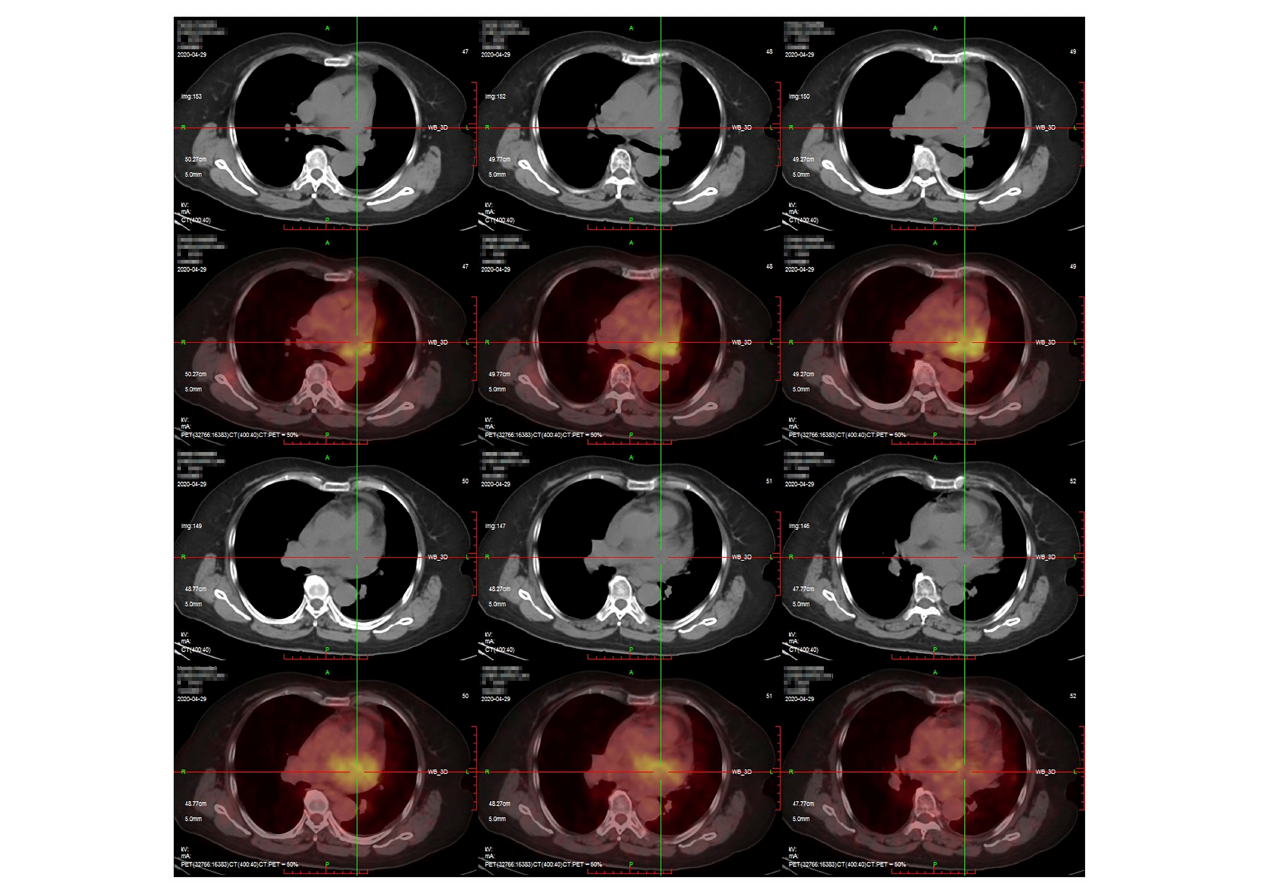
FIGURE 1 | Positron emission tomography/computed tomography findings. Intense fluorodeoxyglucose uptake was observed in the pericardium with a maximum standardized uptake value of